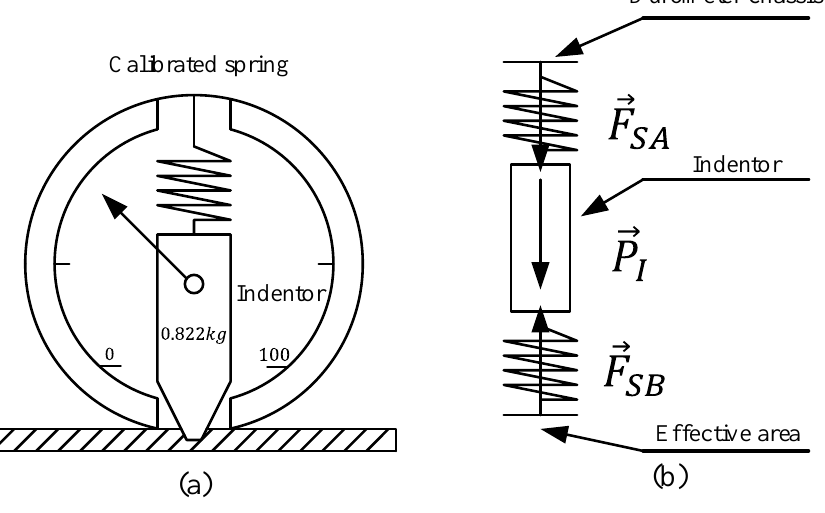
Figure 3. Basic scheme of a shore durometer ( a ) and the equivalent model of its principle ( b